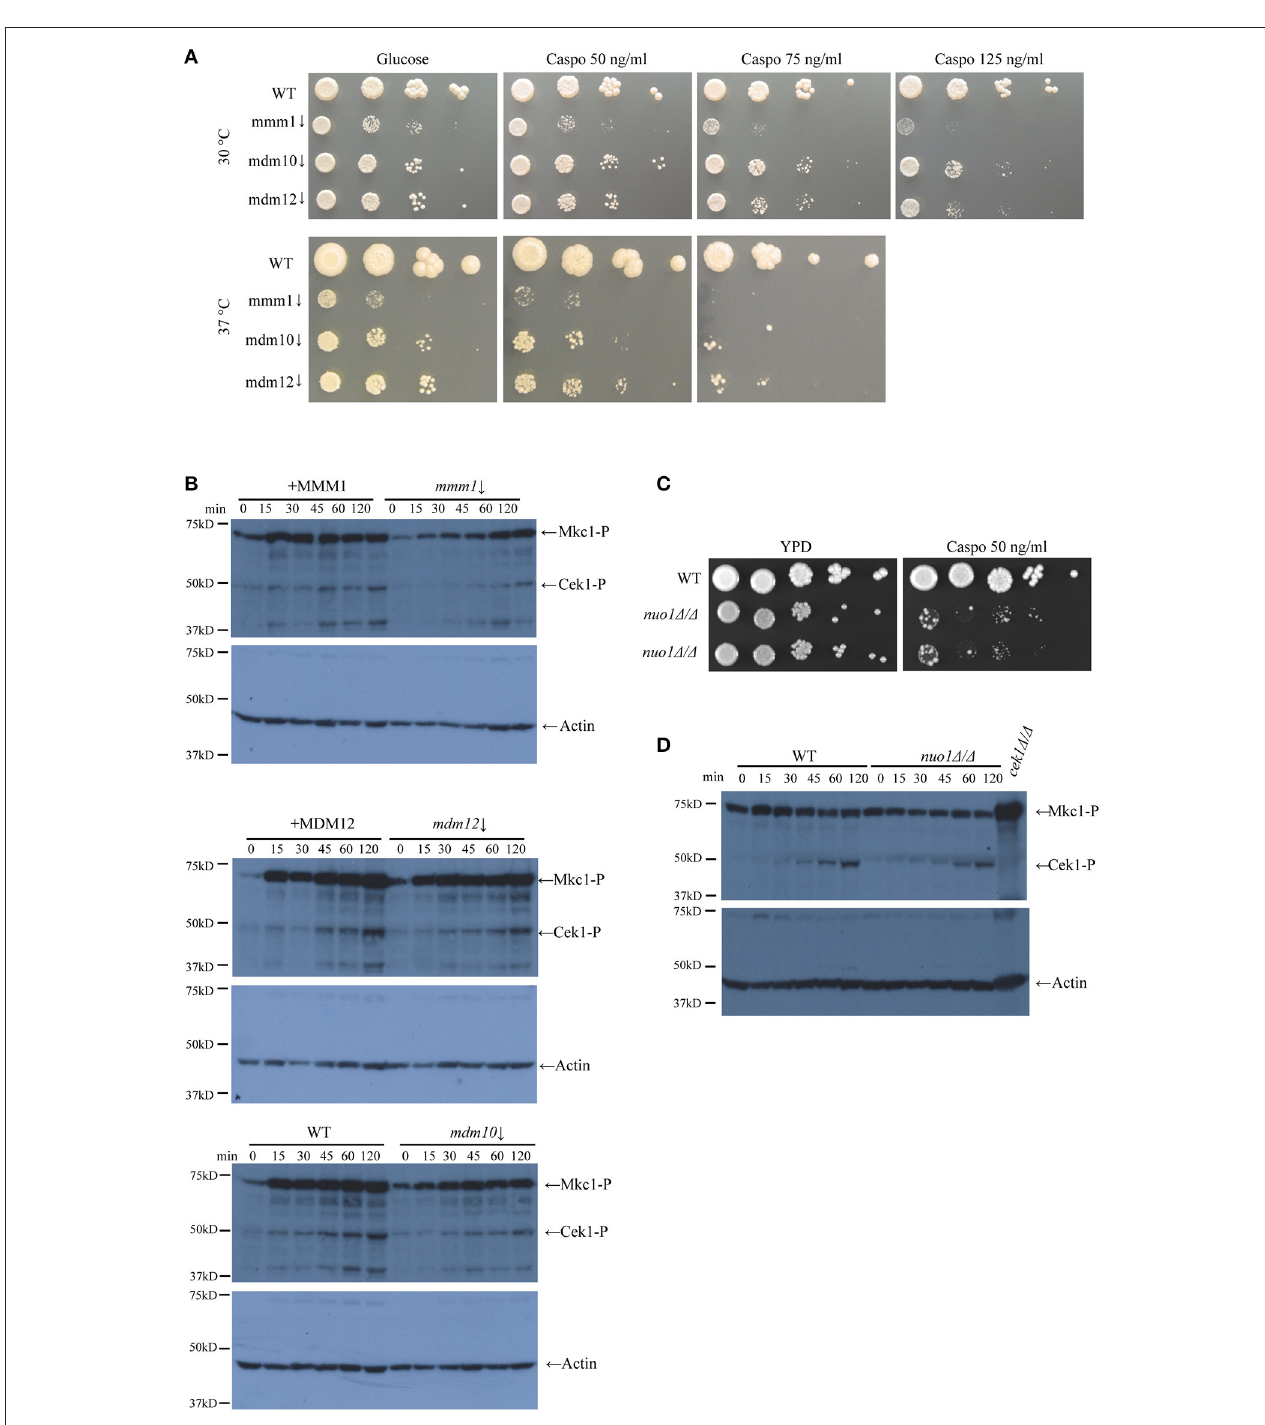
FIGURE 4 | ERMES activity is needed for optimal growth of C. albicans upon cell wall stress. (A) Conditional mutants of ERMES ( mmm1 ↓ , mdm1 0 ↓ mdm12 ↓ ) were grown in synthetic media + Met/Cys, in the presence of the indicated concentrations of caspofungin (Caspo). Ten-fold serial dilutions were spotted and pictures taken after 3 days of growth at the indicated temperatures. (B) The activation of Cek1 and Mkc1 was tested in the conditional ERMES complex mutants as described in Figure 3A . Strains were grown in synthetic medium with all amino acids and methionine and cysteine were added in to repress ERMES gene expression. As controls, either the wild type strain or the complemented strains were used, as indicated in the Figure. (C) Growth of wild type and nuo1 1 / 1 mutants was tested on YPD plates in the presence of 50ng/ml caspofungin (Caspo). Ten-fold serial dilutions were spotted and plates were photographed after 2 days of growth at 30 ◦ C. (D) Activation of Mkc1 and Cek1 in nuo1 1 / 1 was tested as described in Figure 3A .